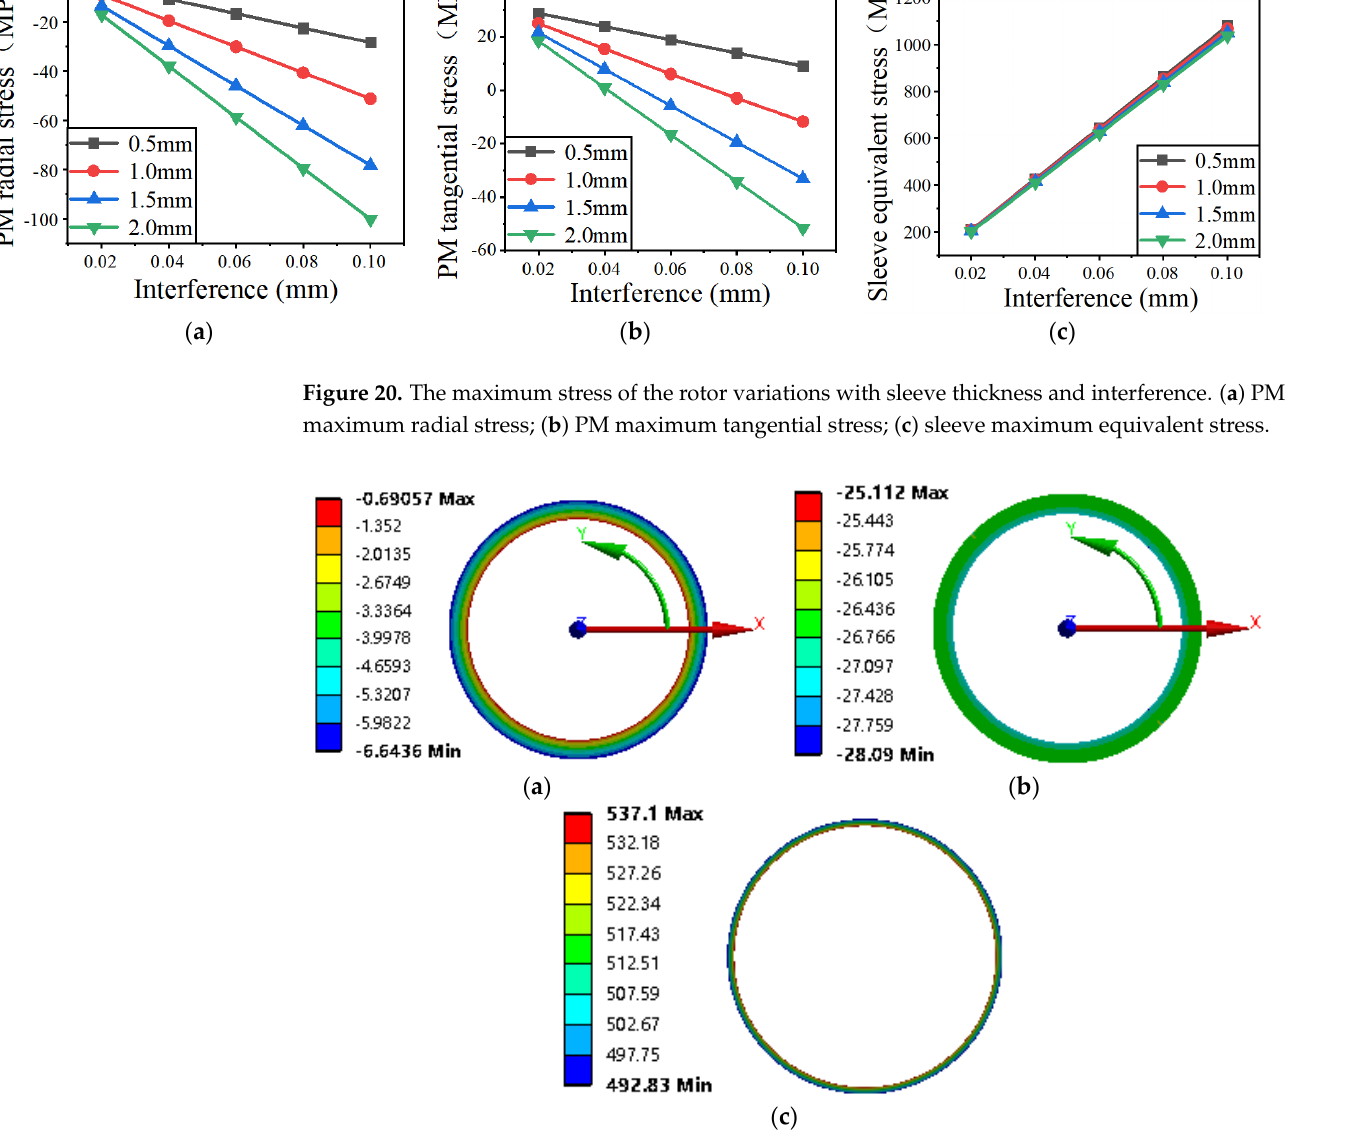
Figure 20. The maximum stress of the rotor variations with sleeve thickness and interference. ( a ) PM maximum radial stress; ( b ) PM maximum tangential stress; ( c ) sleeve maximum equivalent stress.